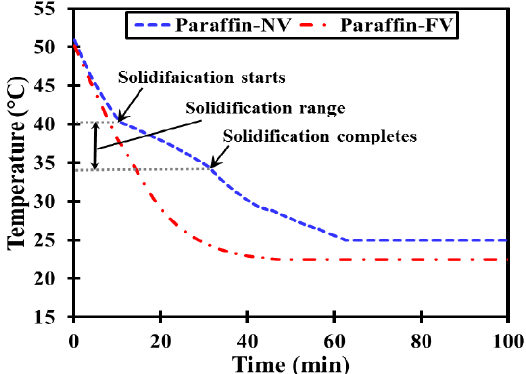
Figure 9. Transient cooling curve for paraffin represented by HS bottom surface temperature under NV and FV.